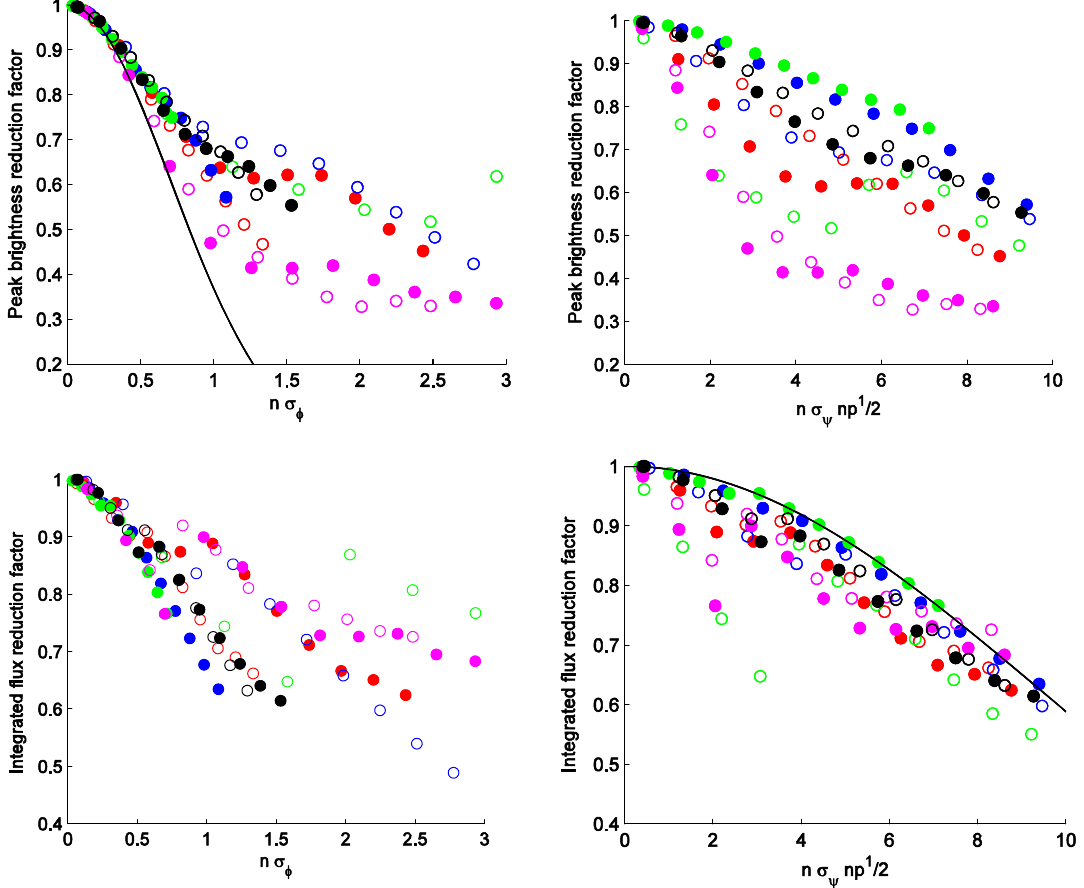
FIG. 20. Reduction factors in peak brightness (upper plots) and integrated flux (lower plots) as functions of rms phase error (left- hand plots) and rms local phase error (right-hand plots) in radians, for the ten devices of Table I with corresponding symbols, including the effects of emittance and energy spread, and integration over an aperture. Solid lines: upper-left plot—Eq. (1); lower-right plot— Eq. (6). Devices 1, 2, 9, and 10 use APS parameters as in Fig. 18, other devices: energy ¼ 3 GeV , rms horizontal/vertical electron beam divergences ¼ 24 : 2 = 4 : 2 (cid:9) rad , energy spread ¼ 9 : 6 (cid:7) 10 (cid:1) 4 . Pinhole sizes are set to collect approximately 95% of the peak flux in the